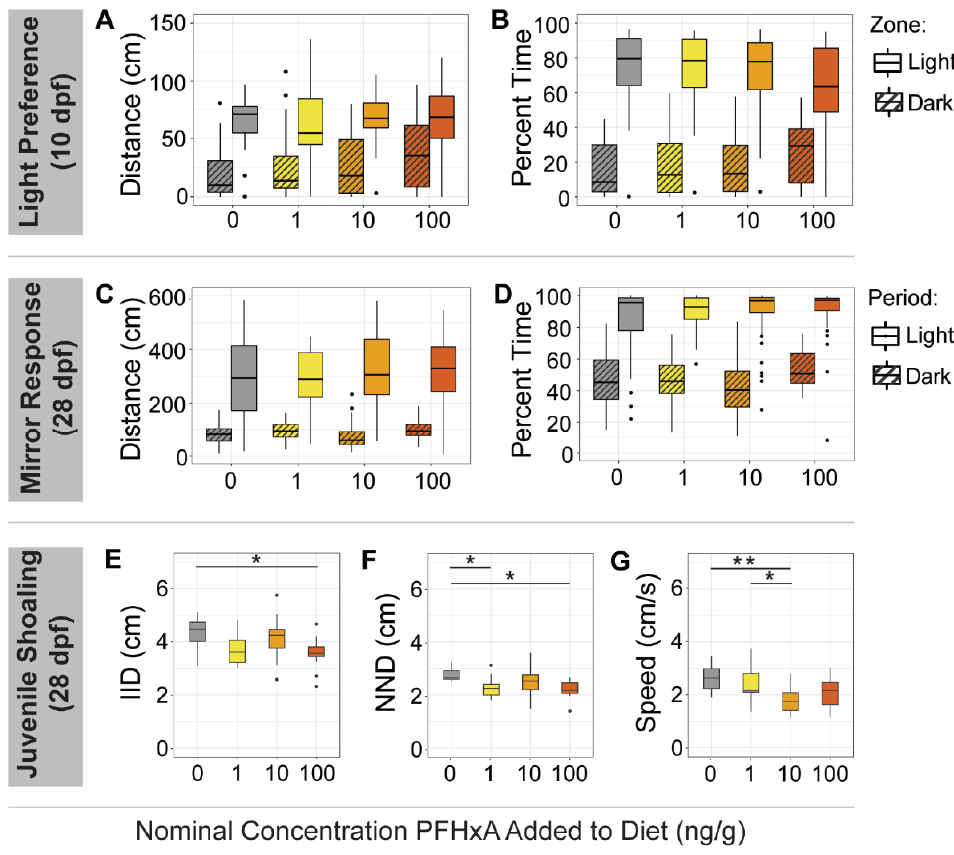
Figure 7. F1 Juvenile Behavior Assays. F1 zebrafish exposure groups are indicated on the x-axes and by color (left to right, grey: 0 ng/g, yellow: 1 ng/g, orange: 10 ng/g, and red: 100 ng/g PFHxA added to the F0 diet). During the light/dark preference assay at 10 dpf, no significant differences in total distance swam ( A ) or percent time spent ( B ) in the light or dark (striped boxes) assay zones were observed between exposure groups. In the mirror response assay at 28 dpf, no differences in distance traveled ( C ) or percent time spent ( D ) in the mirror zone during the light or dark periods (striped boxes) were noted. During the juvenile shoaling assay at 28 dpf, the average inter-individual distance (IID) of the 100 ng/g group was significantly lower than that of controls ( E ). Average nearest neighbor distance (NND) of the 1 and 100 ng/g groups were less than controls ( F ). Speed of the 10 ng/g group was significantly lower than that of controls ( G ). Significant differences between exposure groups are indicated on the plots (* p < 0.05; ** p < 0.005).